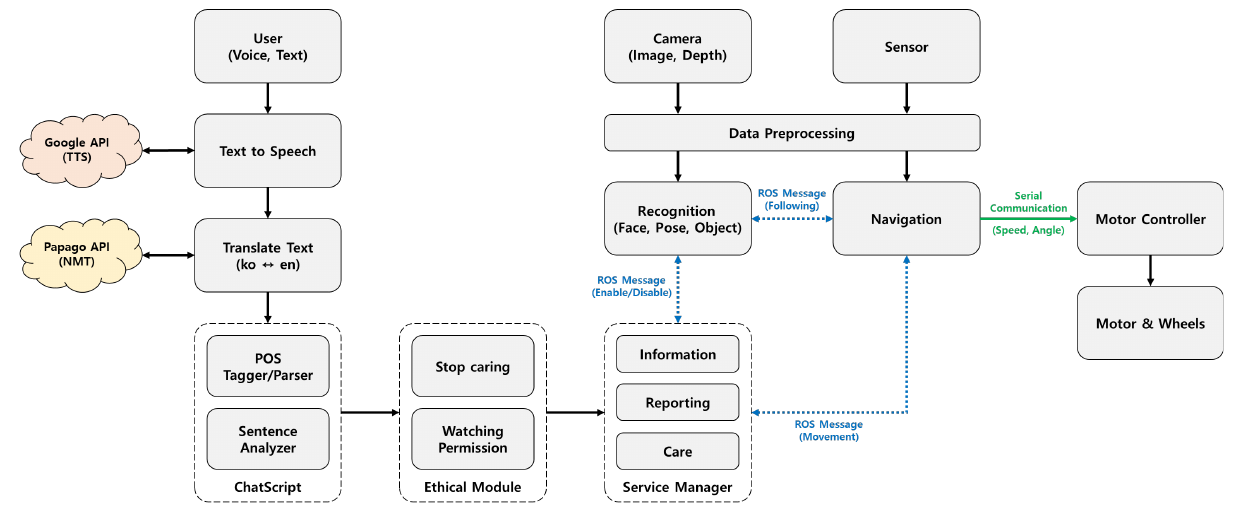
Figure 12. Flow diagram of internal processes executed during conversations between Dori and the user.